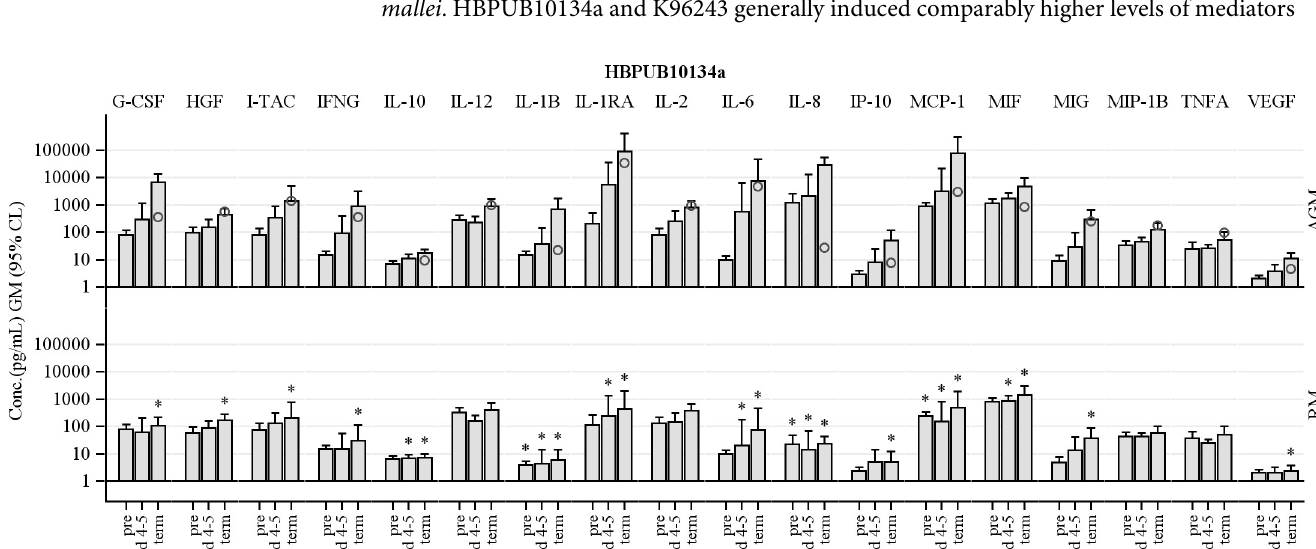
� indicates significant change from baseline by Welch’s t -test ( P < 0.05). a ND, not determined. Standard reference range for LDH was 402–1364 U/L.